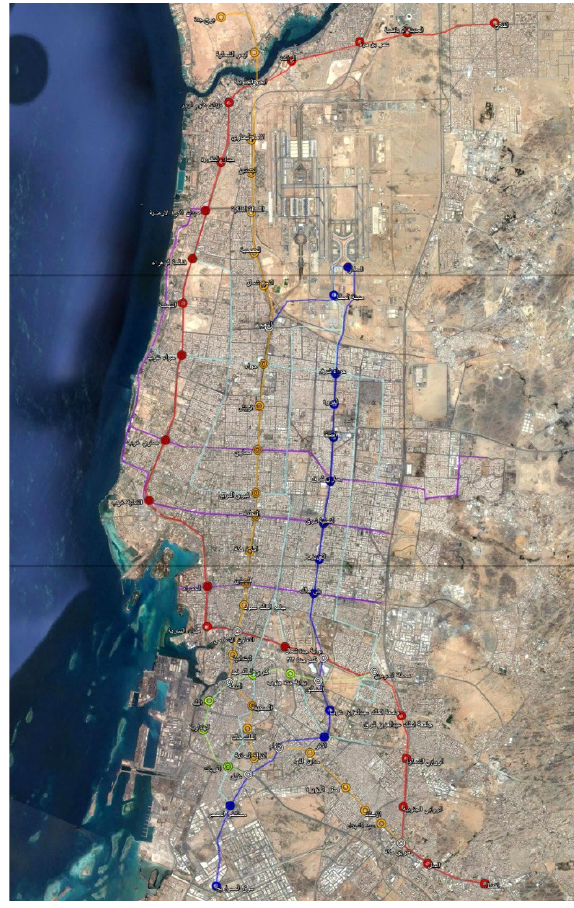
Figure 3. The Jeddah Metro map consists of four lines. Source: HiJazzey